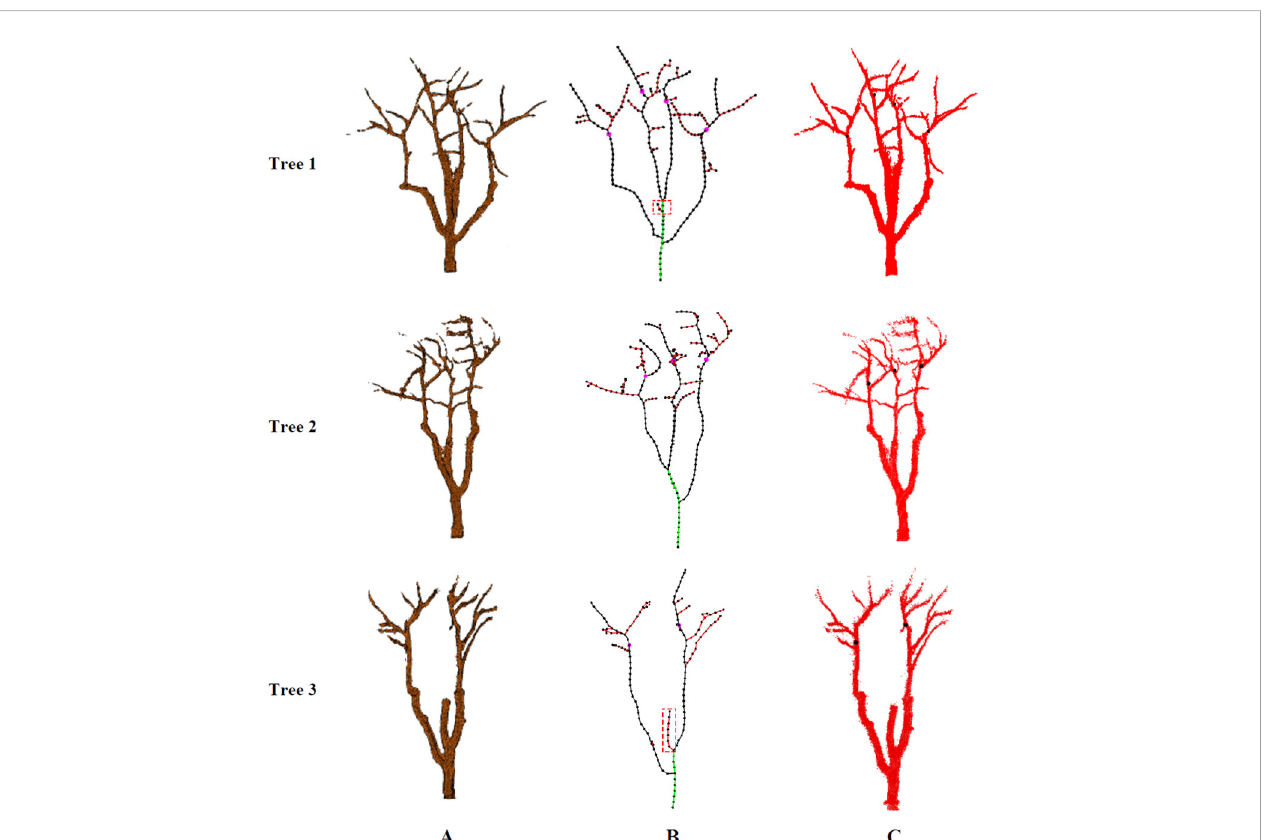
FIGURE 10 Results of skeleton analysis and pruning points identi fi cation. (A) Model of jujube tree. (B) Identi fi cation of pruning points based on skeleton analysis. (C) Mapping of pruning point positions in reconstructed point